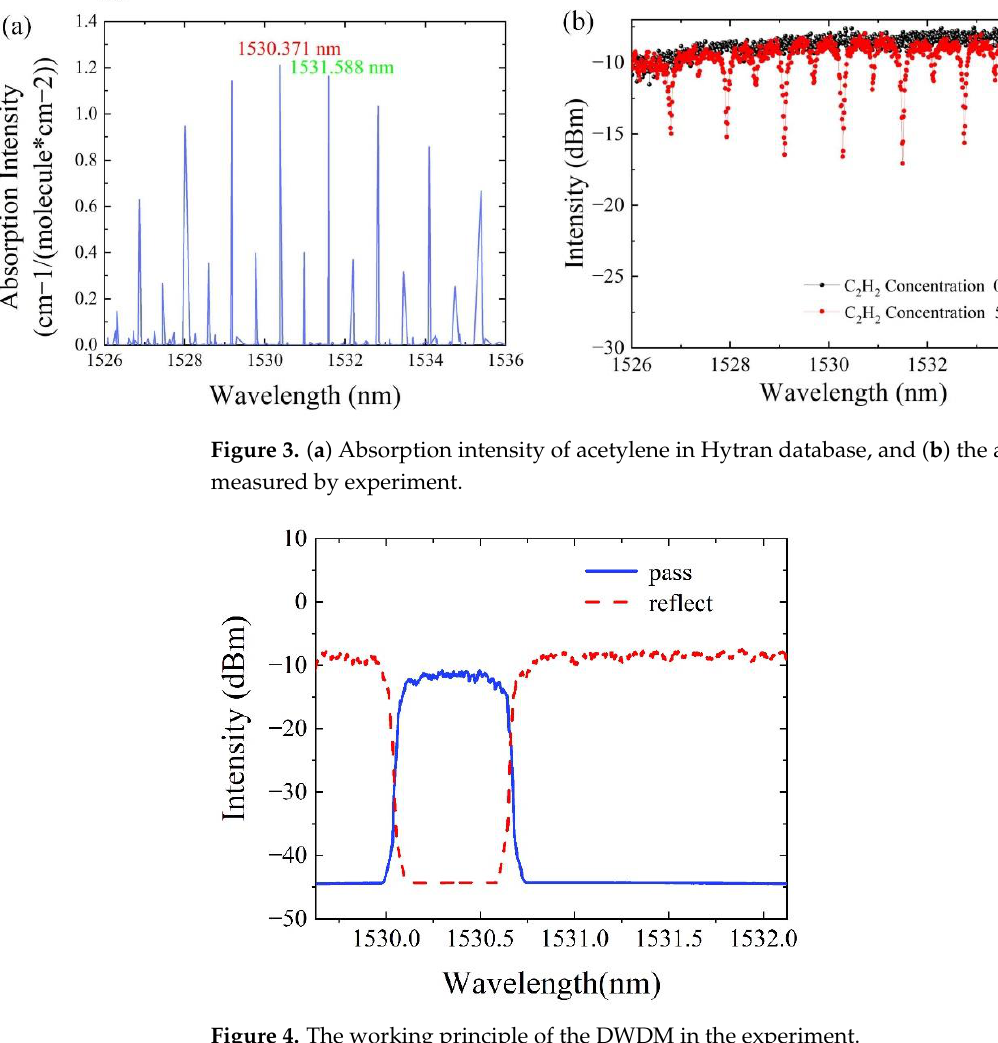
Figure 3. ( a ) Absorption intensity of acetylene in Hytran database, and ( b ) the absorption intensity measured by experiment.